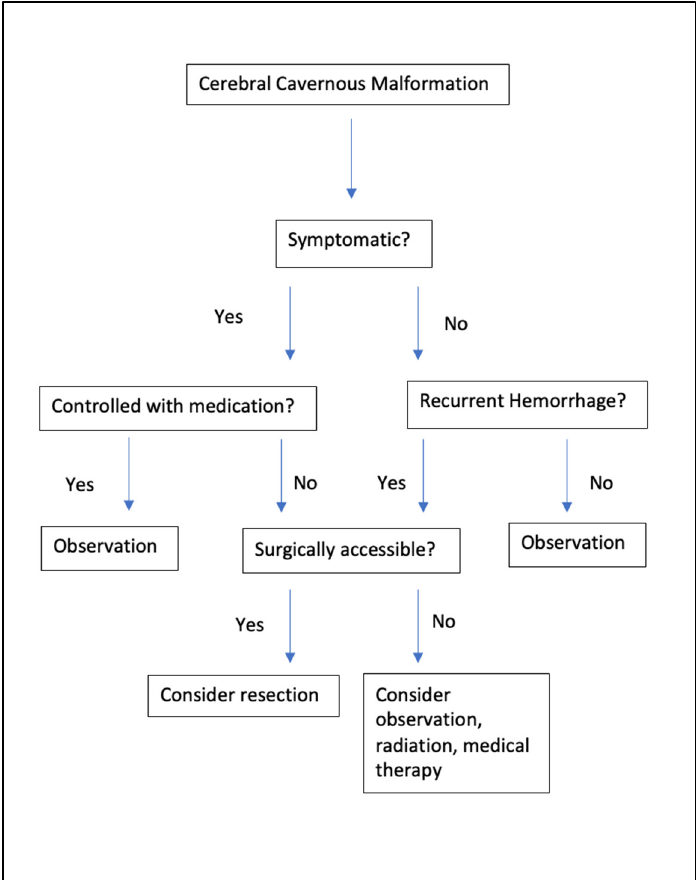
Figure 2. Management algorithm for CCMs.